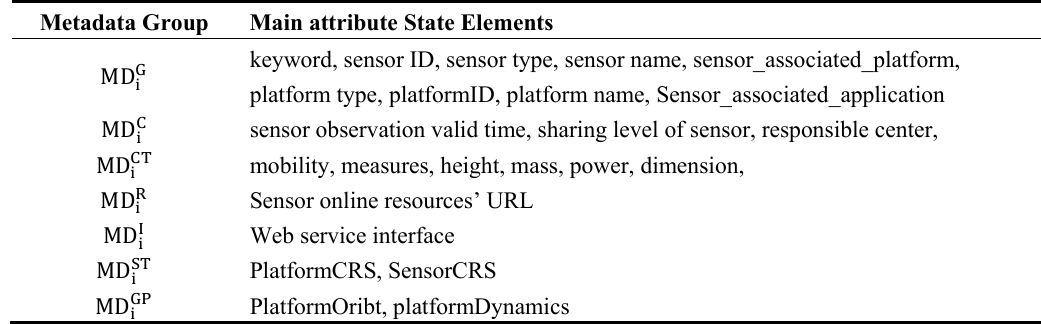
Table 1. Seven metadata groups’ attributes of remote sensing satellite sensors.